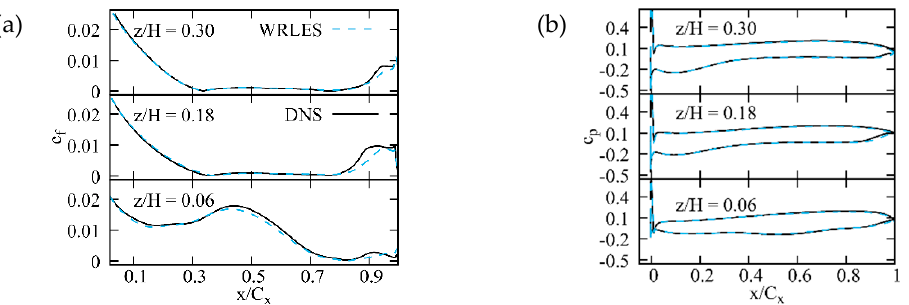
Figure 8. Comparison of WRLES and DNS results along the blade at different spanwise positions. ( a ) Friction c (cid:2916) along the SS and ( b ) pressure c (cid:2926) along PS and SS.